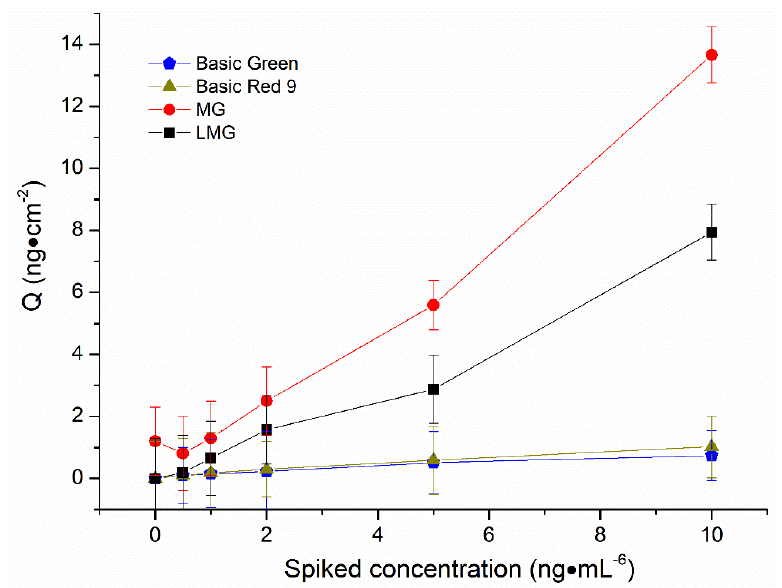
Figure 8. Comparison of MG-MIM extraction for basic green, basic red 9, MG and LMG at the concentration of 10.0 ng.mL − 6.